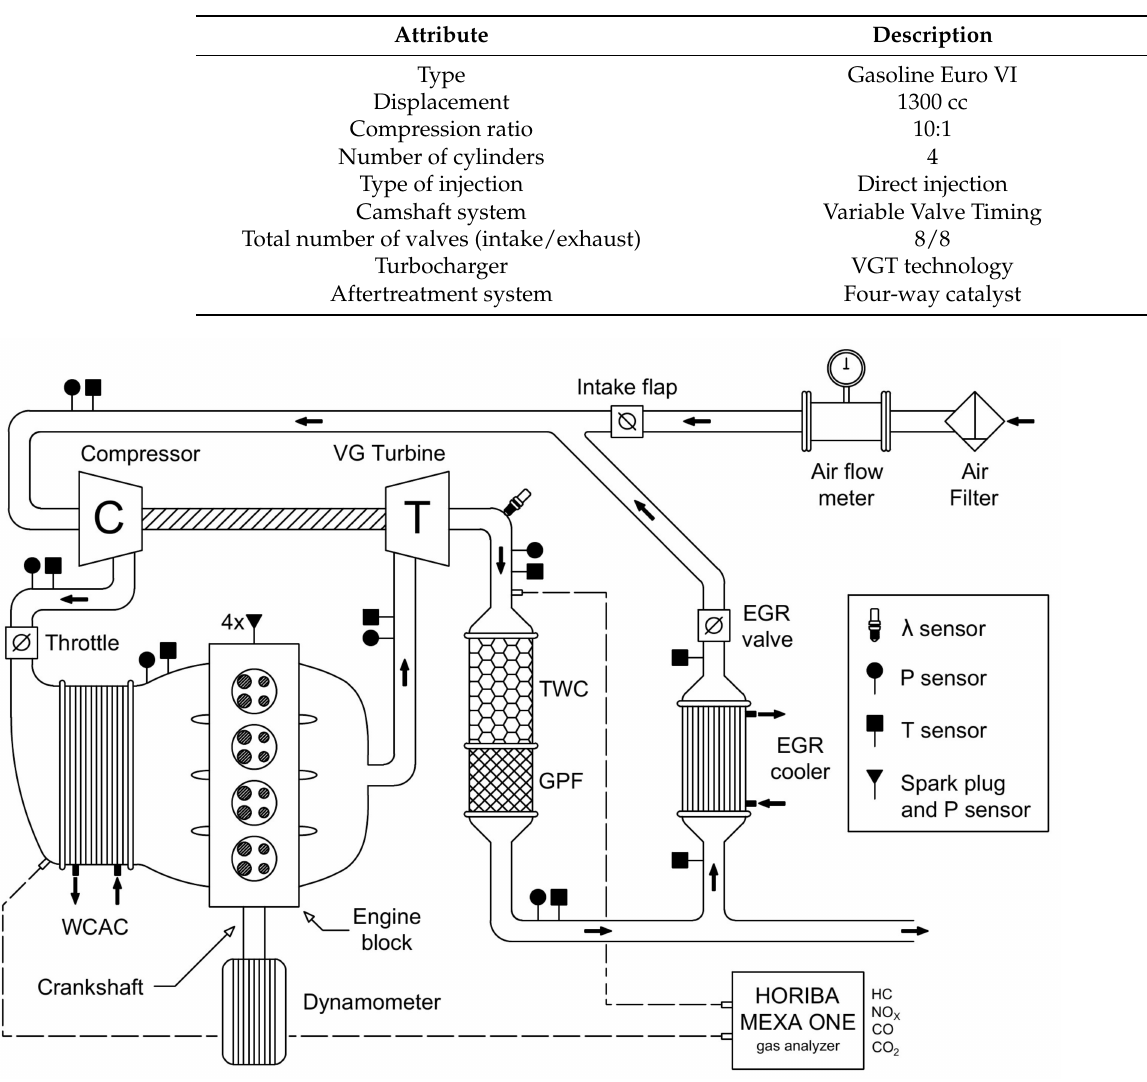
Table 1. Engine’s attributes.